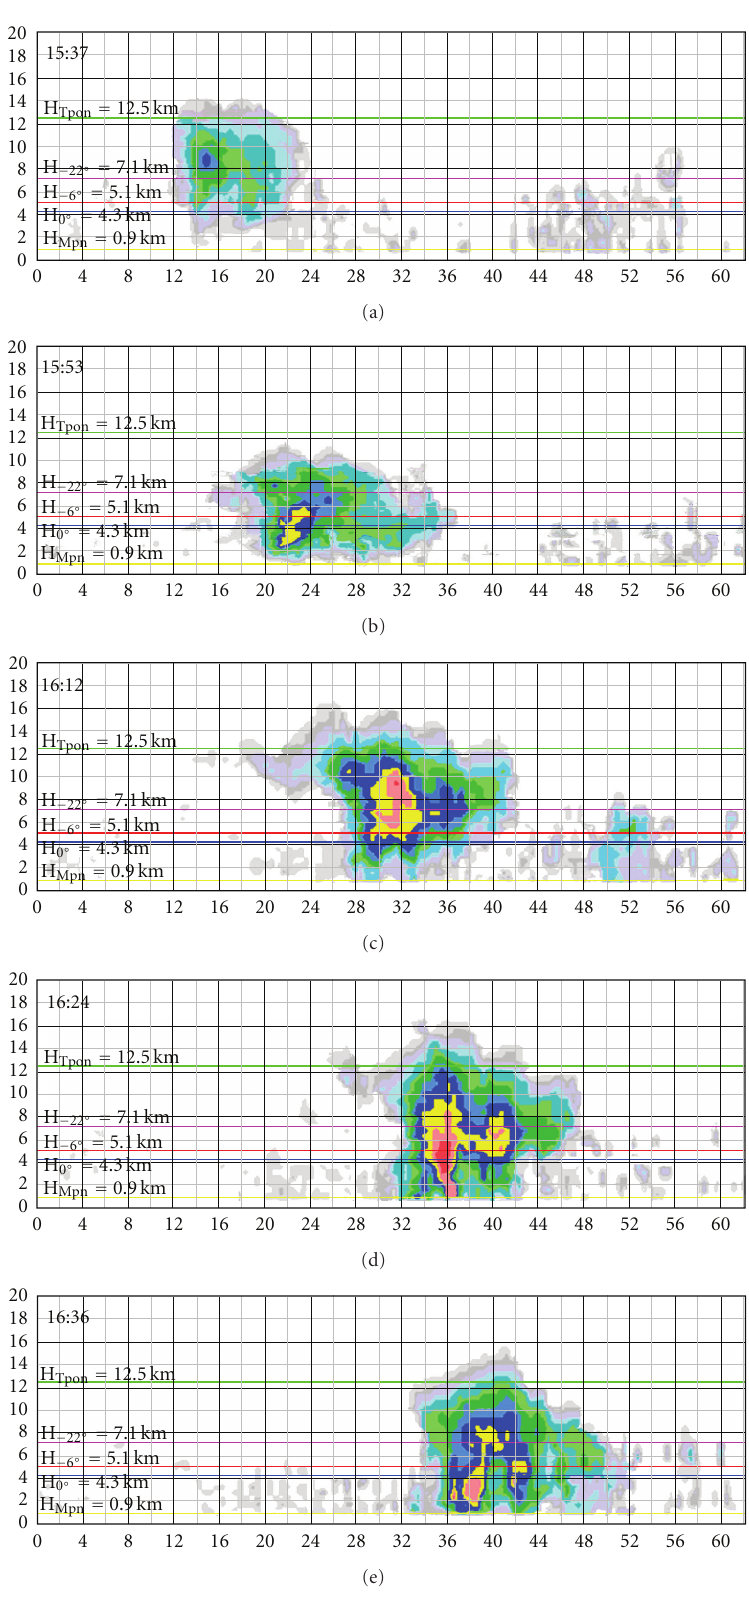
Figure 4: Radar reflectivity (dBZ) along the SW-NE vertical cross-section. Observations from WSR-74 S/X radar upgraded with ASU-MRL at di ff erent observational times, starting at 15:37